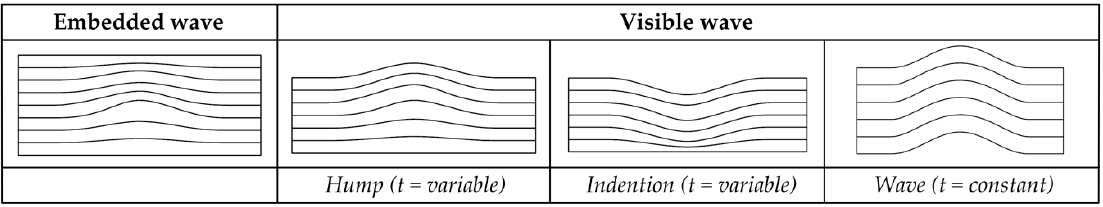
Figure 30. Iso-phase vs. random-phase waviness.